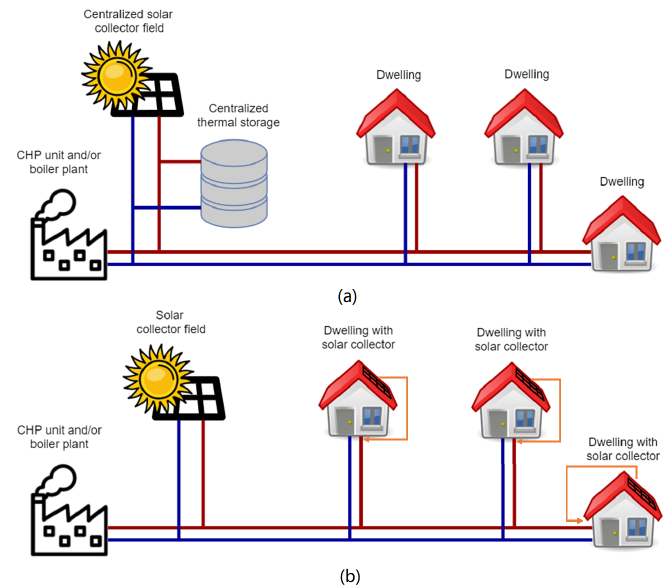
Figure 7. Scheme of solar DH systems, ( a ) centralized, ( b )